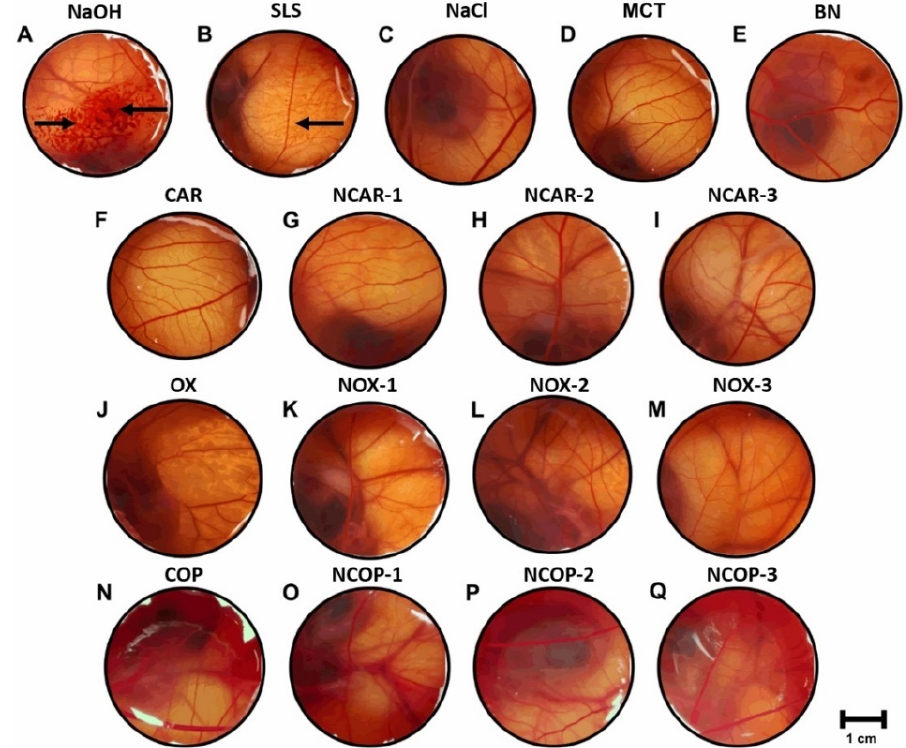
Figure 4. Images of HET-CAM assay after 5 min exposure (n = 6/group): ( A ) 0.1 M NaOH (IS 13.35 ± 0.22); ( B ) 1.0% w / v Sodium lauryl sulfate (IS 10.62 ± 0.22); ( C ) 0.9% w / v NaCl (IS 0.00); ( D ) MCT— Medium chain triglycerides (IS 0.00); ( E ) BN—Blank nanoemulgel (IS 0.00); ( F ) CAR—10.0% w / w β - caryophyllene in MCT (IS 0.00); ( G ) NCAR-1—nanoemulgel of β -caryophyllene (IS 0.00); ( H ) NCAR-2 (IS 0.00); ( I ) NCAR-3 (IS 0.00); ( J ) OX—5.6% w / w caryophyllene oxide in MCT (IS 0.00); ( K )